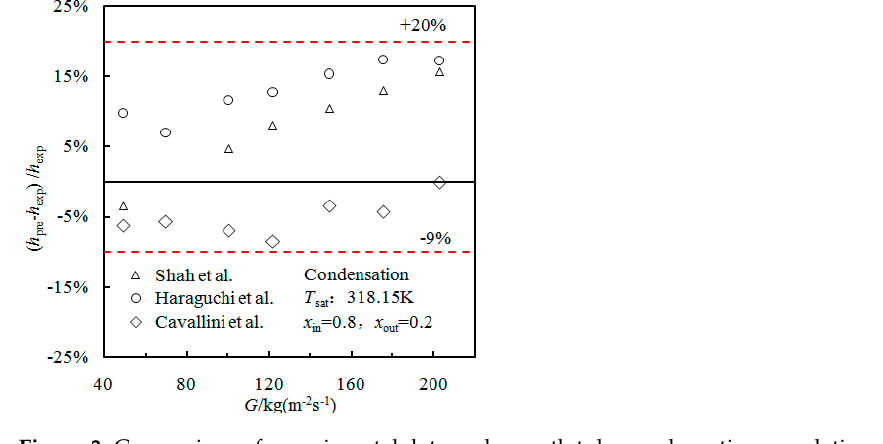
Figure 3. Comparison of experimental data and smooth tube condensation correlations.